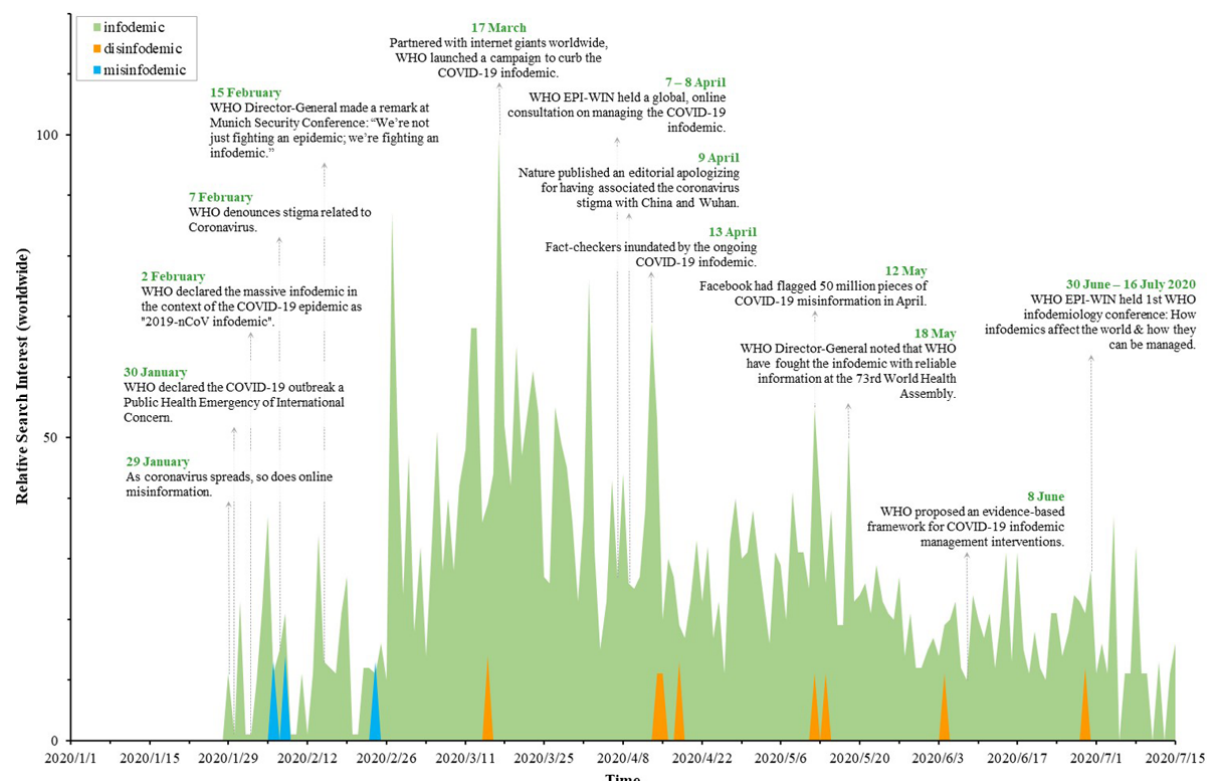
Figure 6. Illustration on the relative search interest of information contagion from around the world. EPI-WIN: Information Network for Epidemics; WHO: World Health